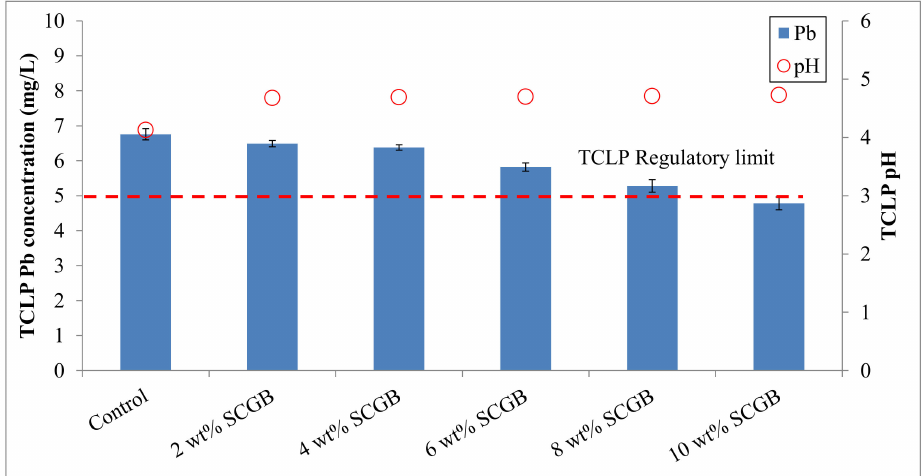
Figure 4. TCLP Pb concentrations for the control sample and spent-coffee-grounds-derived biochar (SCGB) treated